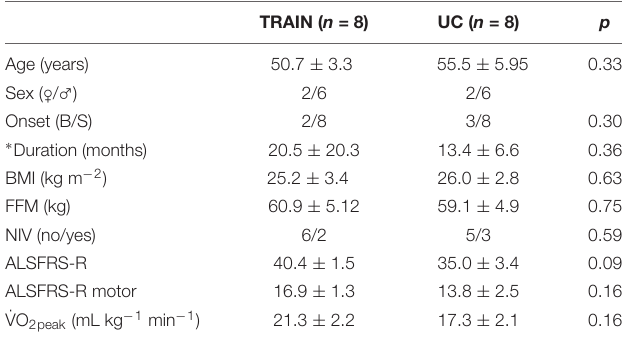
TABLE 1 | Demographic and clinical characteristics of patients with amyotrophic lateral sclerosis (ALS) in the training (TRAIN) and usual care (UC) groups before the 12-week intervention